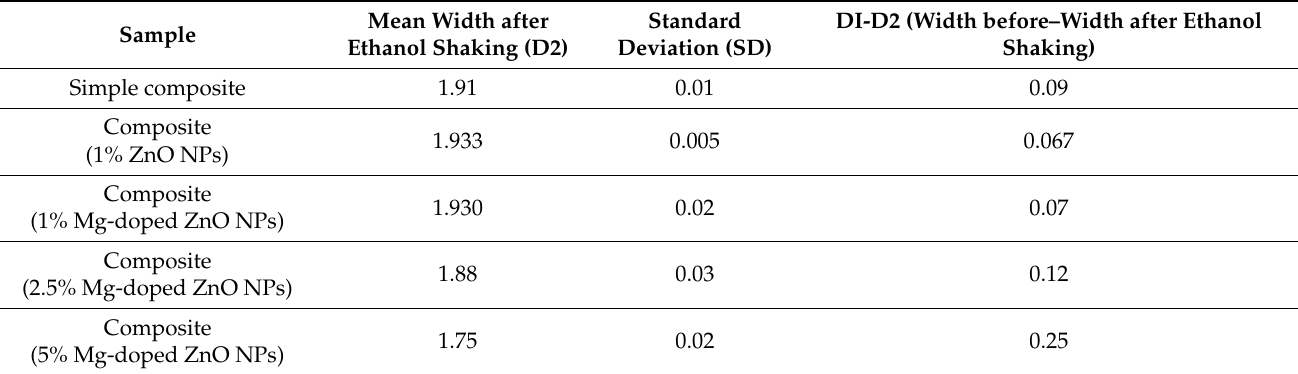
Table 2. The difference in width of composites after ethanol shaking test.